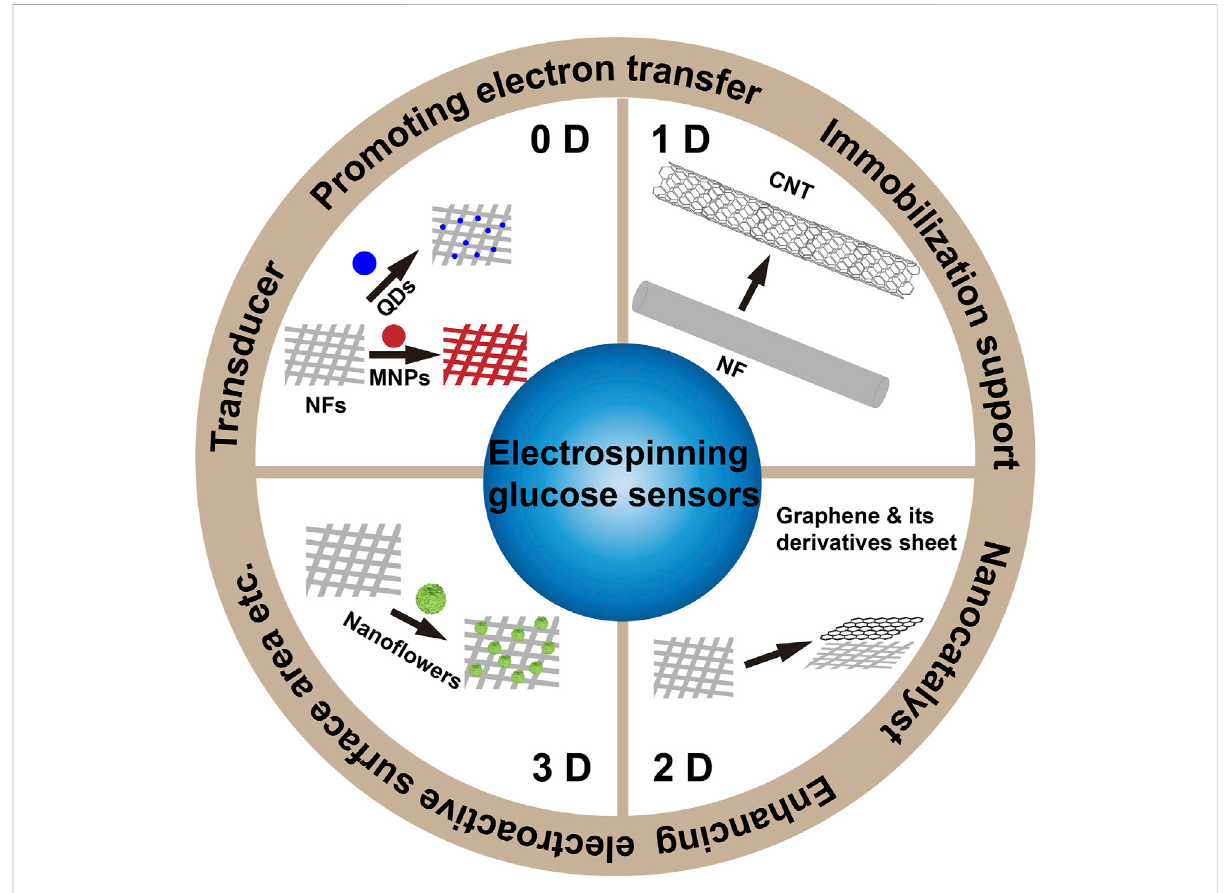
FIGURE 6 Summary of the nanomaterials in electrospun glucose